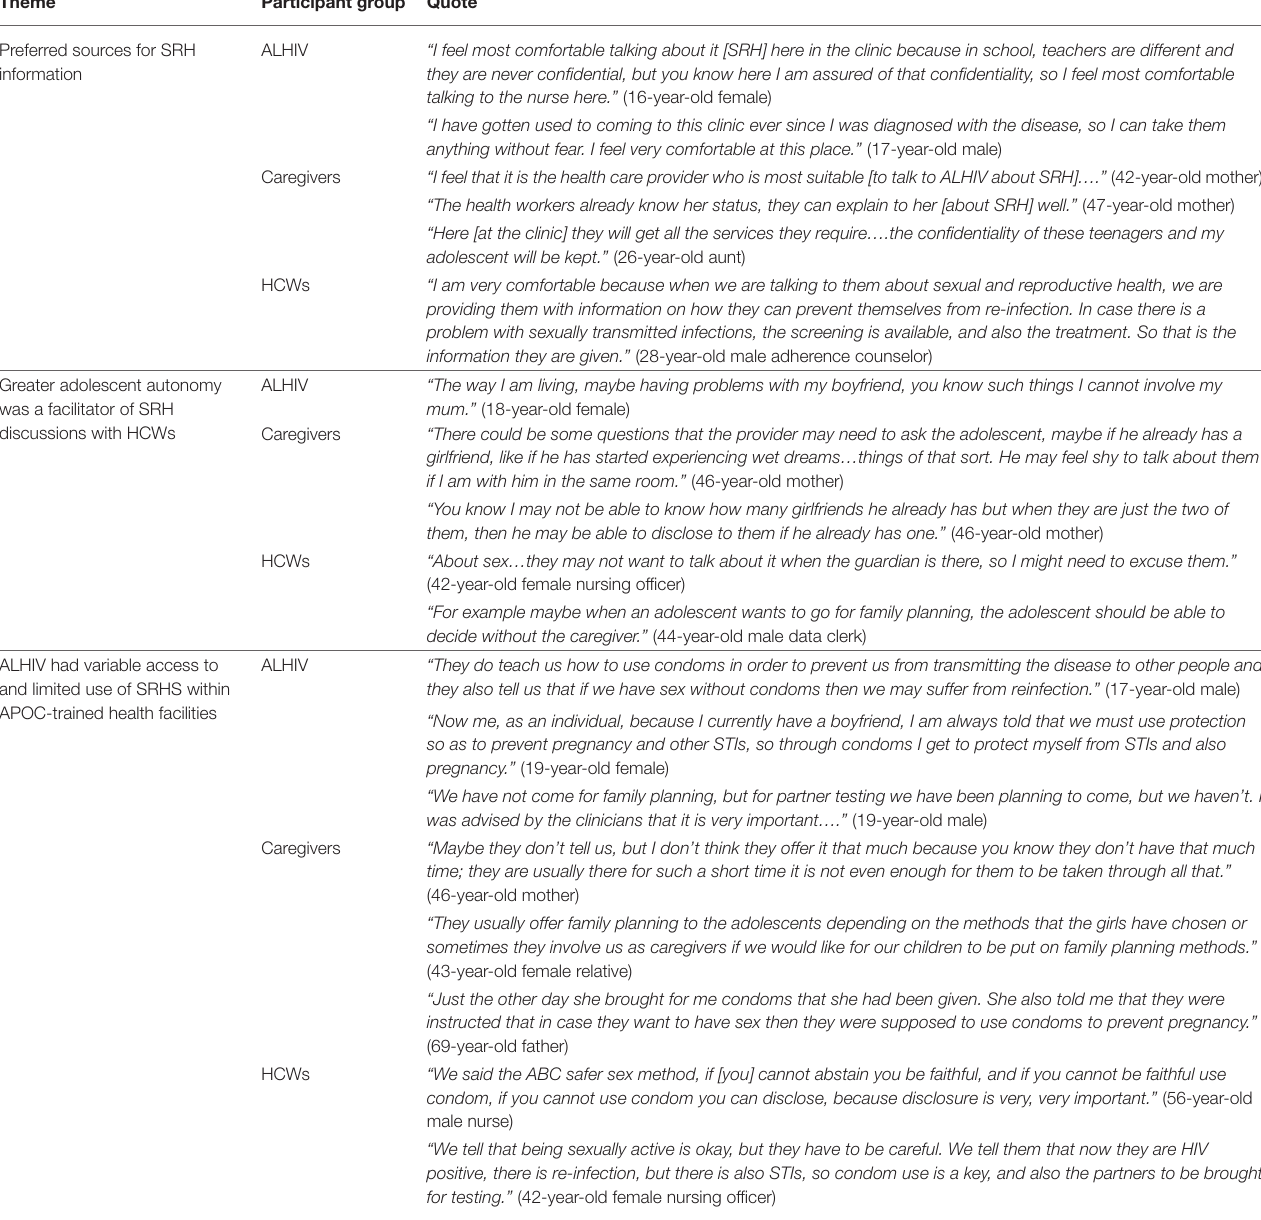
TABLE 3 | Additional representative quotes by